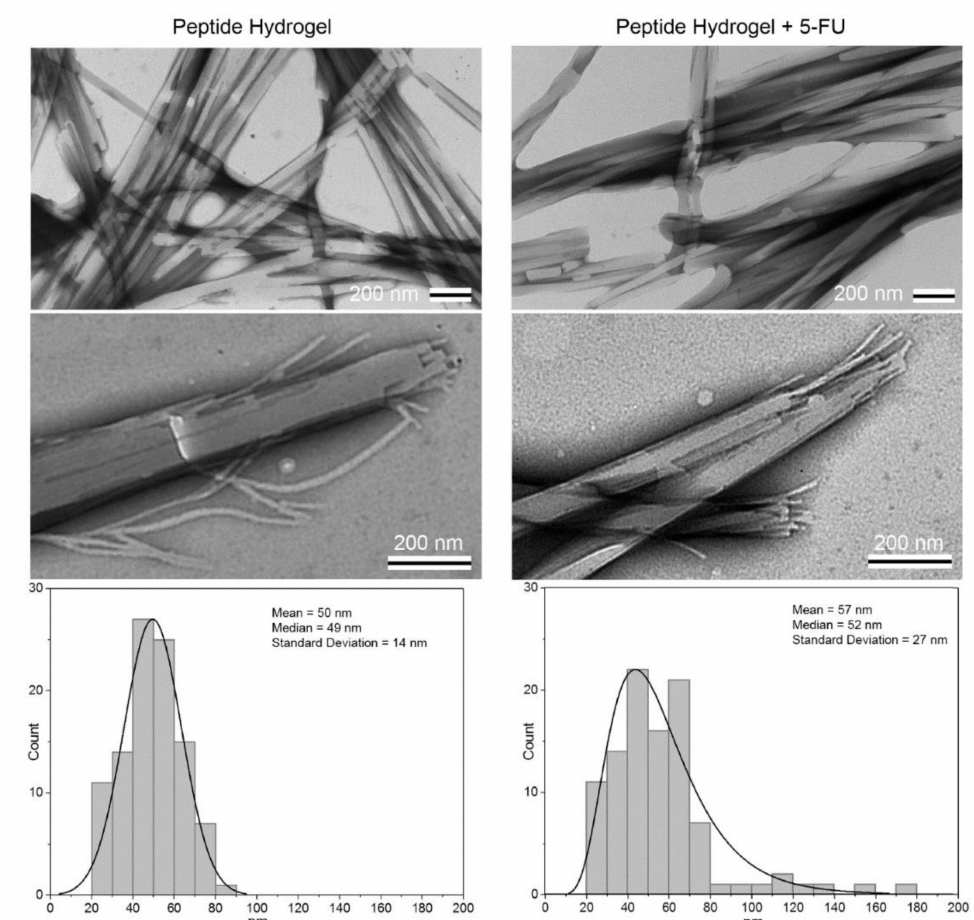
Figure 5. TEM micrographs and plots of fiber diameter measurements showcasing the morpholog- ical differences in heterochiral tripeptide hydrogels from the presence of the antineoplastic drug, 5-fluorouracil (5-FU). Reproduced under the terms of the Creative Commons Attribution License from [69]. ©2019 The Authors. Published by MDPI